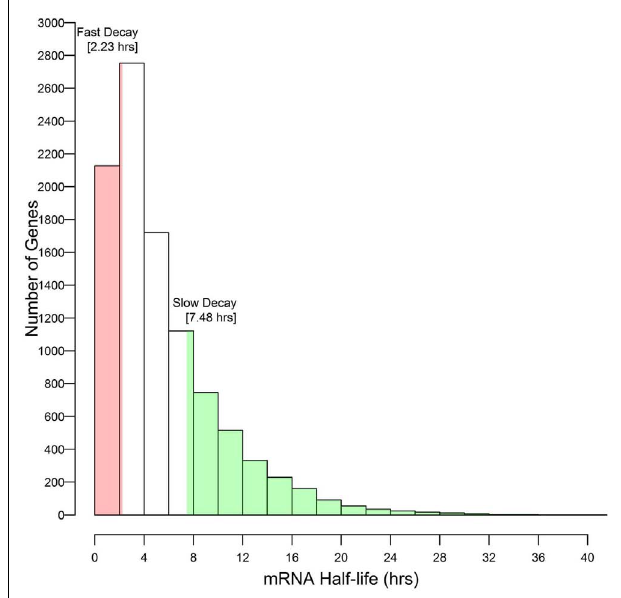
FIGURE 4 | Selection of outlier genes with fast and slow rates of mRNA decay relative to the distribution of mRNA half-lives